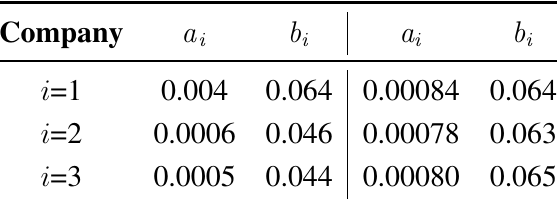
Table 2. Parameters of the cost model for each utility company based on the time-of-use (ToU) pricing policy: from 0:00 to 7:00 on the left and from 8:00 to 24:00 on the